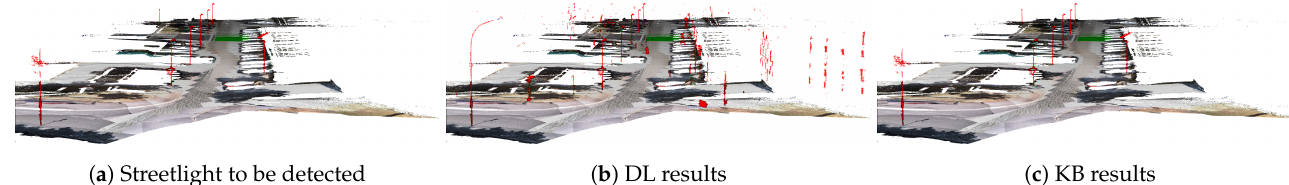
Figure 11. Streetlight semantic segmentation results